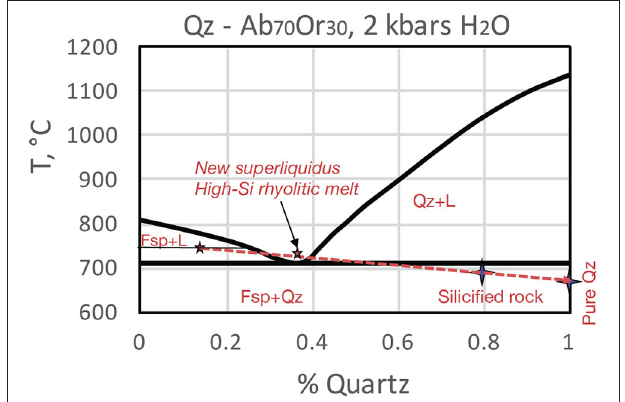
FIGURE 8 | Temporal evolution of the Karymshina Volcanic Complex in comparison to Gorely volcanic center (0–0.35Ma, Seligman et al., 2014), other volcanoes nearby, and Akhomten granitic massif. Symbols are the same as on Figure 7 . Units are plotted in relative random order except the ones indicated by arrows with ages from Table 1 and Figure 2 based on geochronology of this work and previously reported in Bindeman et al. (2010). Notice overall decrease in Sr and O isotopes, and increase in Nd isotopes from pre to postcaldera intrusions, and an increasing homogenization of isotopes with youth. Sr isotopes are adjusted to their initial